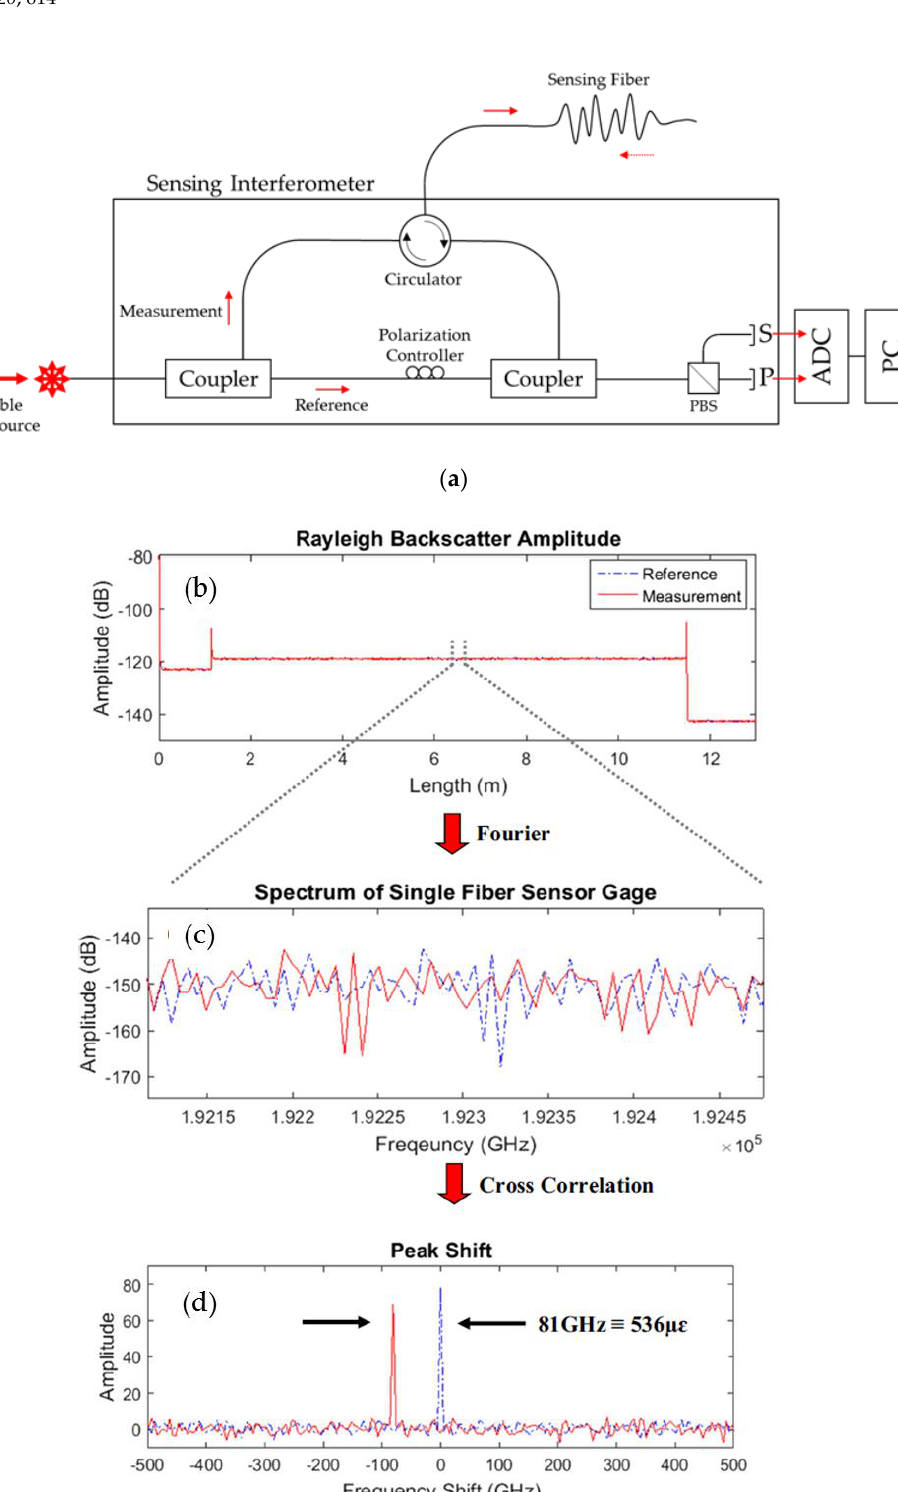
Figure 1. ( a ) Schematic of basic principle of optical frequency domain recorder (OFDR). ( b ) Example signature Rayleigh scatter measurement with reference and measured strain (from external stimuli) values, where ( c ) an inverse Fourier transform is applied from the gage length showing ( d ) a cross-correlation of the two spectra resulting in peak shift between the reference measurement and measured strain, after [18].